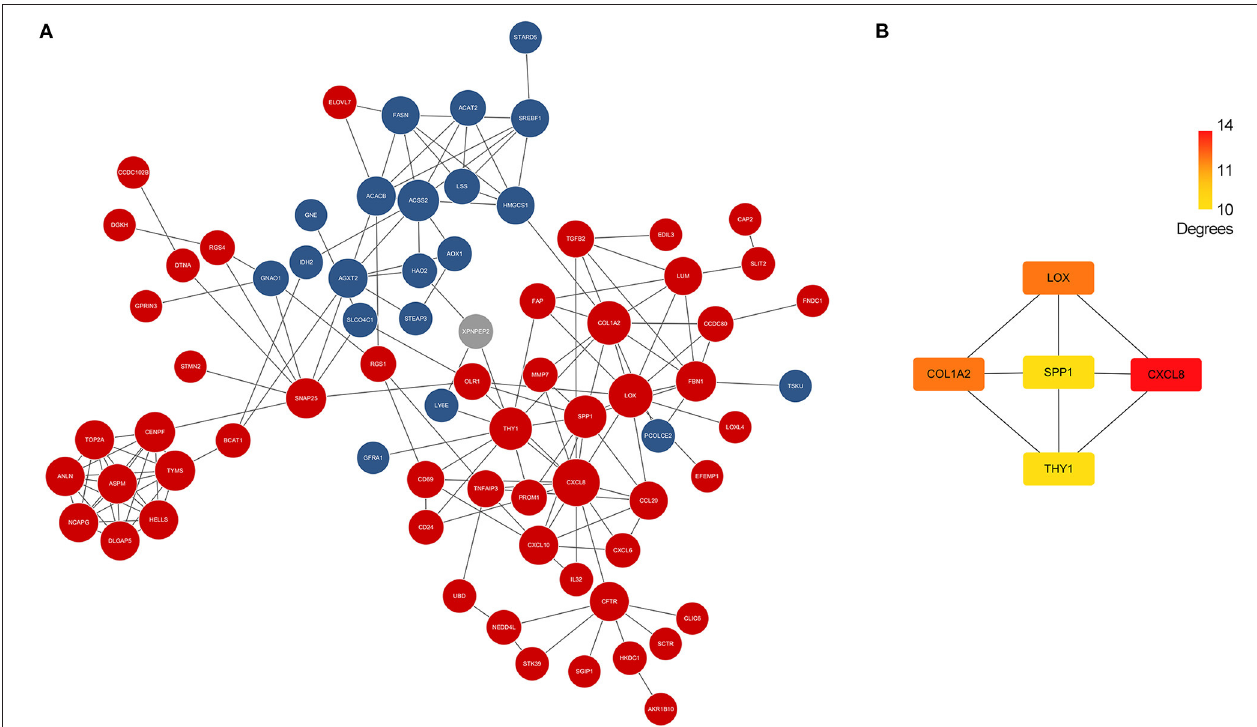
FIGURE 3 | PPI network of DEGs and hub genes. (A) PPI network of DEGs in GSE46960 and GSE159720. Red spots and blue spots represented upregulated genes and downregulated genes in both data sets, respectively, while gray spots represented an inconsistency of expression in each data set. (B) Hub genes identified by Cytohubba. CXCL8 was the top hub gene with 14 degrees, followed by COL1A2 , LOX , SPP1 , and THY1 . PPI, protein–protein interaction; DEGs, differentially expressed genes.